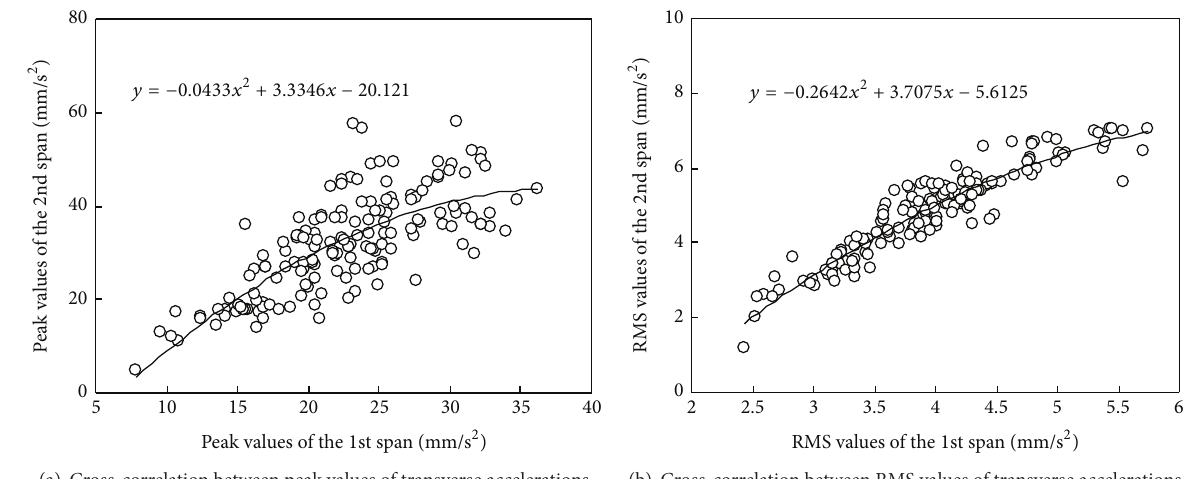
(a) Cross-correlation between peak values of transverse accelerations (b) Cross-correlation between RMS values of transverse accelerations Figure 4: Cross-correlations between the amplitude parameters of the transverse accelerations measured in the middle of two main spans.